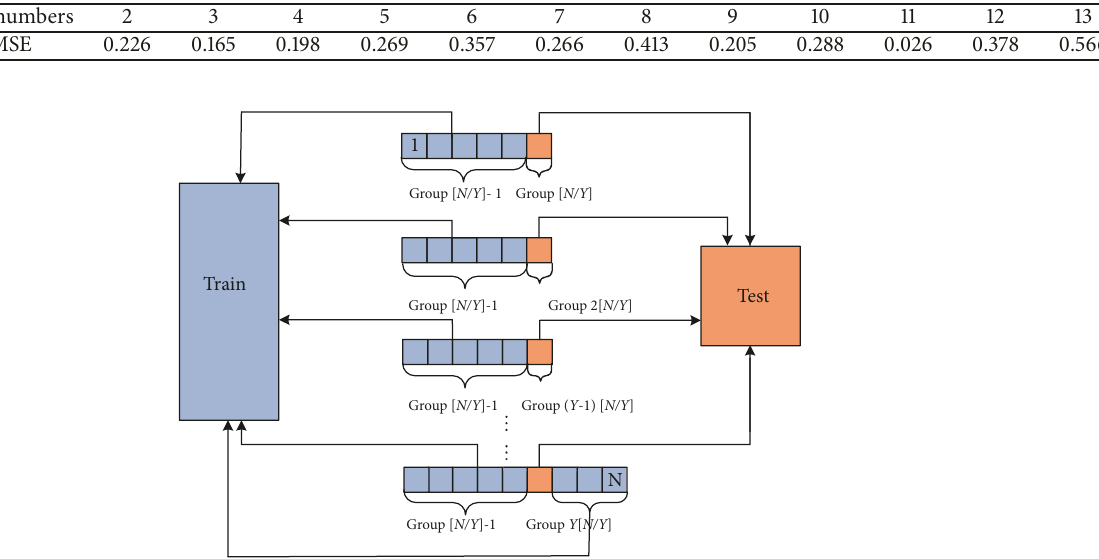
Figure 4: Schematic diagram of homogenization